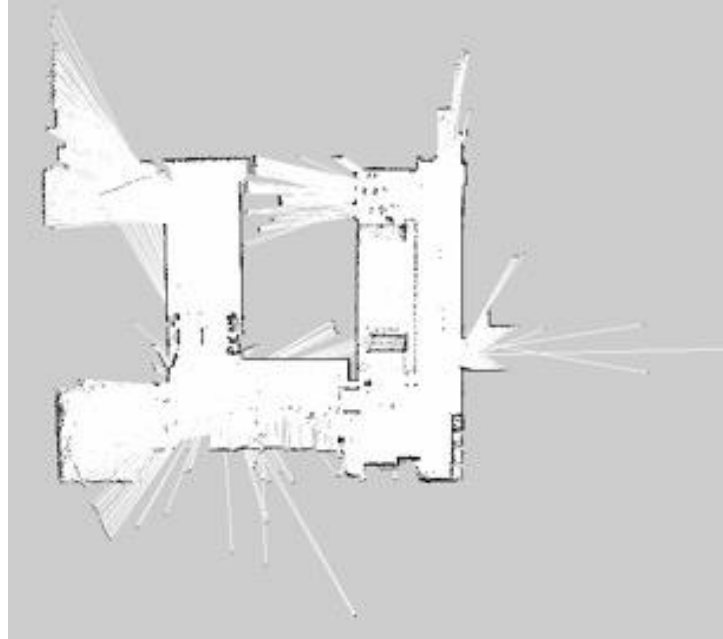
Figure 23. The map using Gmapping (YDLiDAR X4).